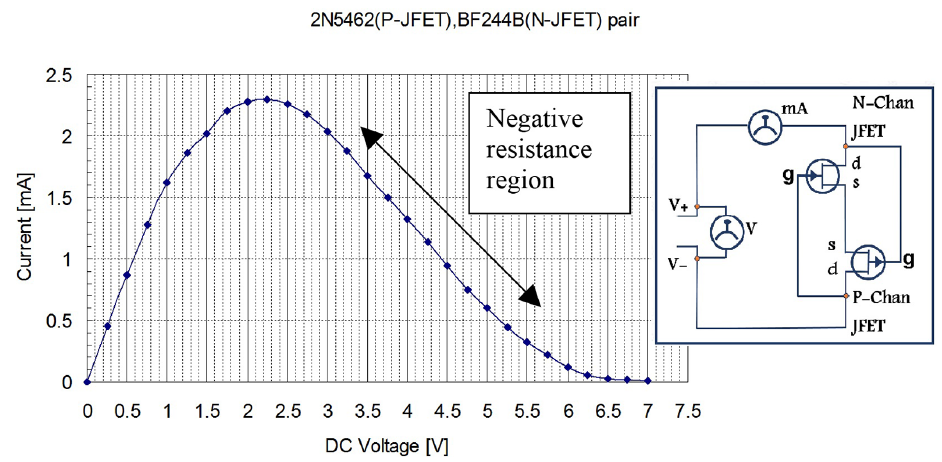
Figure 23. The 2N5462 and BF244B JFET pair lambda diode characteristic. Electronic circuit design published by Butler (1997).